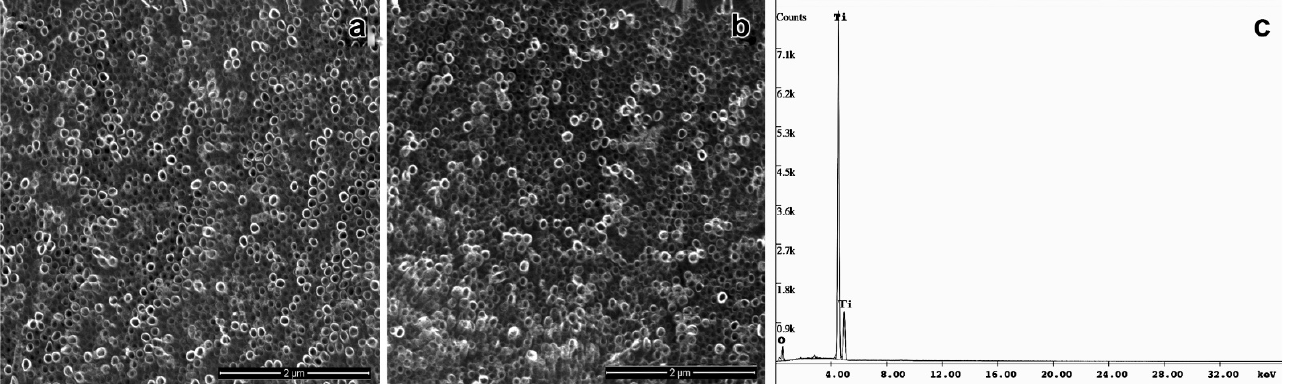
Figure 1. Ultrastructural assay of TiO 2 modified nanotubes by high resolution scanning microscopy ( a ) bare TiO 2 NT, ( b ) OniL-TiO 2 NTs (200 μ g/mL), and ( c ) EDS-spectrum of TiO 2 NTs.